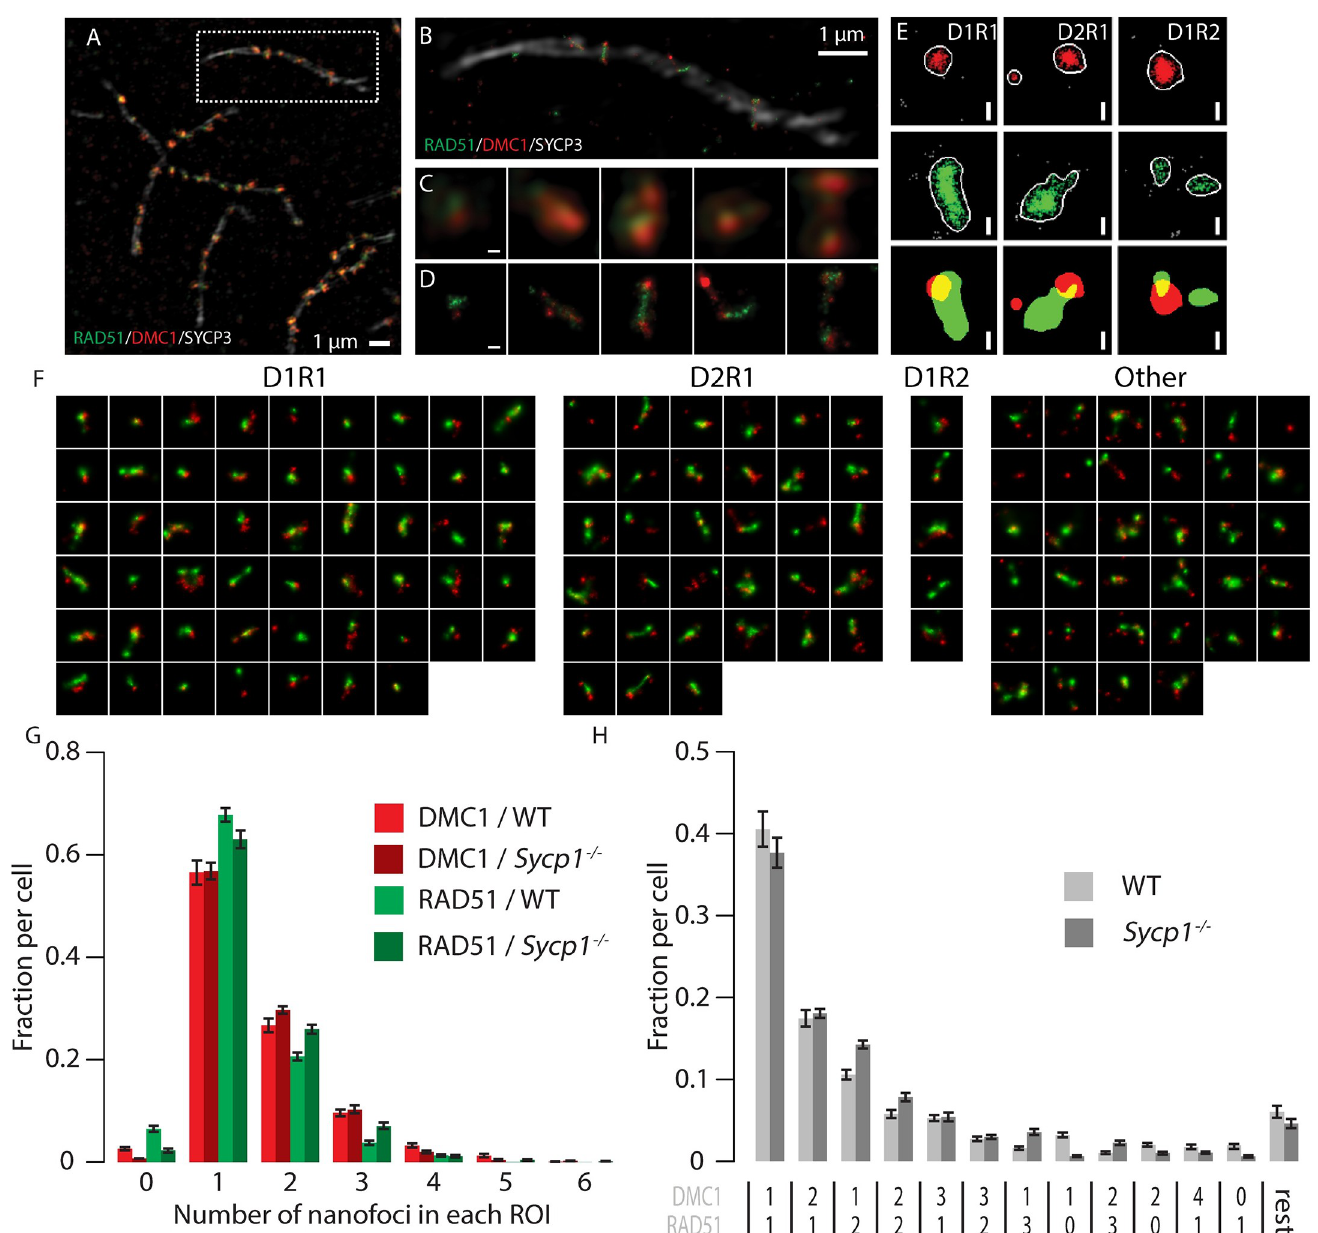
Fig 2. Meiotic DSB foci in super-resolution. A) Cropped region from a SIM image of a spread mouse late zygotene nucleus immunostained with primary antibodies for RAD51, DMC1, and SYCP3, and appropriate secondary antibodies conjugated with Alexa 488 (green), Alexa 647 (red), and Alexa 555 (white), respectively. B) SYCP3 SIM overlayed with RAD51/DMC1 dSTORM images of boxed region in A). C) Close-up of single DSB foci present on the synaptonemal complex shown in A). D) The same foci visualized with dSTORM. E) Single DSB foci of three types (left panels D1R1, middle panels D2R1, right panels D1R2) represented by 2 different visualisation/analysis methods: scatter plot of localisations and merged binary representation of the kernel density estimation. F) Compilation of all ROIs of a single late zygotene nucleus (indicated with an asterisk in S2 Fig). ROIs are sorted by their DxRy configuration, from most frequent to rare configuration. G) Fraction of foci containing the indicated number of RAD51 or DMC1 nanofoci per focus as a percentage of the number of foci per genotype. H) fraction of foci containing the indicated combinations of RAD51 and DMC1 nanofoci per focus as a percentage of the number of foci per genotype. Combinations that represented less than 1% of the foci in both wild type and Sycp1 -/- were grouped in the category referred to as rest. Scale bars in C-E represent 100 nm. Error bars represent SEM values. Results of statistical analyses are described in S2 Table.